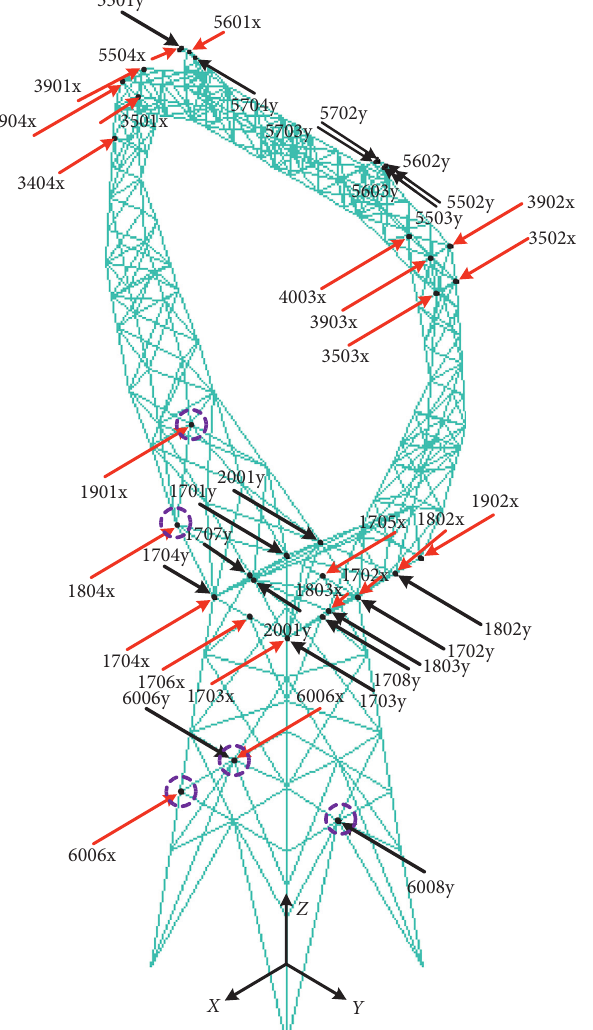
Figure 10: The sensor placement when the number of sensors is